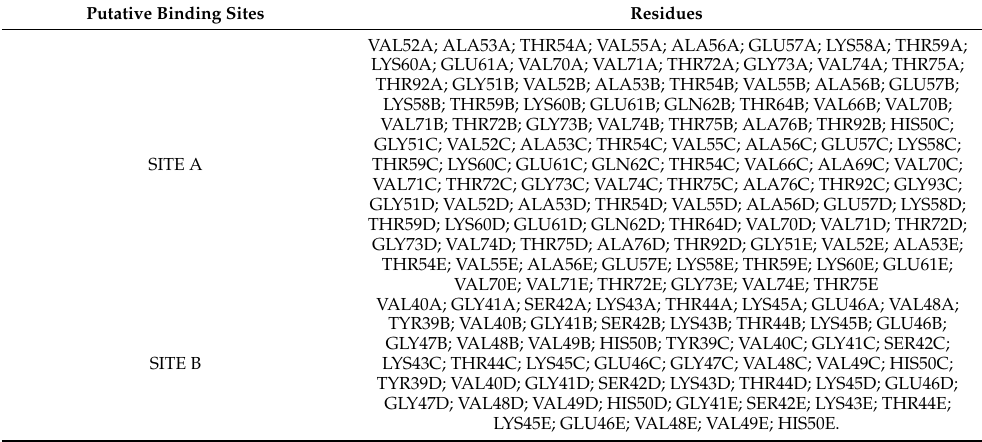
Table 2. List of the protein residues (in different chains) forming the identified binding sites, including residues within 15 Å of any centroid of the Fpocket results for protein